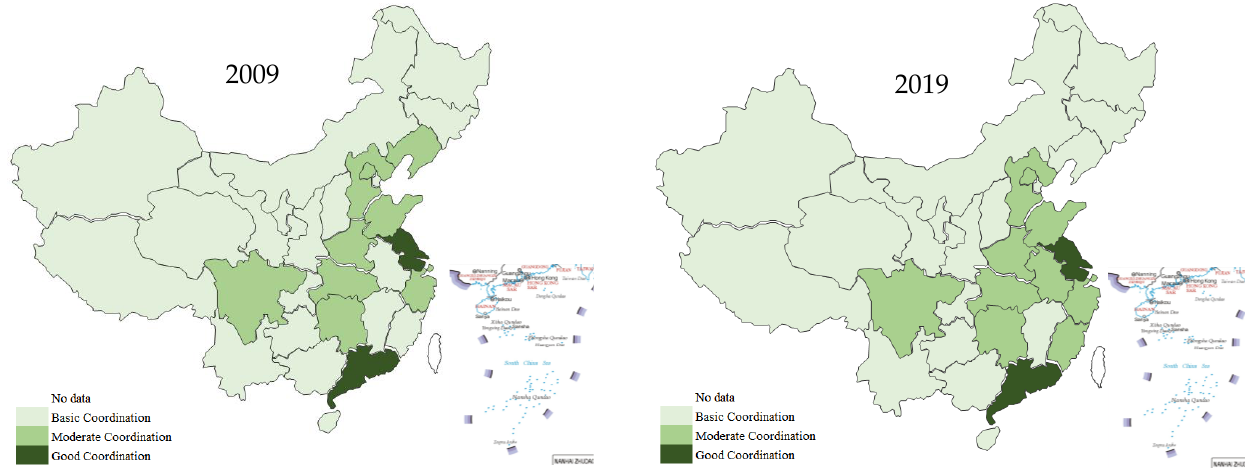
Figure 5. Coordination development level of the aging industry and regional economy.